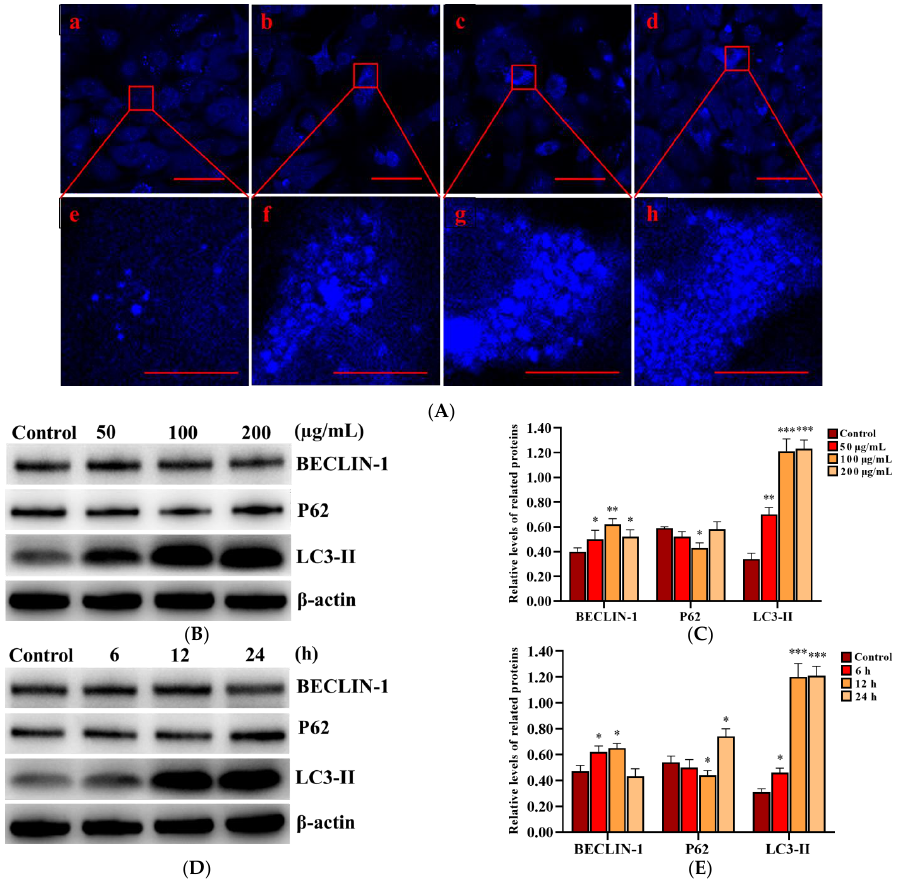
Figure 4. Effect of SNPs on the activation of autophagy in PLCs. ( A ) Fluorescence images of MDC staining. PLCs were exposed to 0, 50, 100, and 200 µg/mL SNPs for 12 h. Scale bar: 50 µm ( A a – d) and 10 µm ( A e – h). ( B ) Western bolt analysis of BECLIN-1, P62, and LC3-II levels. PLCs were exposed to 0, 50, 100, and 200 µg/mL SNPs for 12 h. ( C ) Quantification of the band intensity in B is presented as the relative ratio of target proteins to β -actin. ( D ) Western bolt analysis of BECLIN-1, P62, and LC3-II levels. PLCs were exposed to 100 µg/mL SNPs for 0, 6, 12, and 24 h. ( E ) Quantification of the band intensity in D is presented as the relative ratio of target proteins to β -actin. Data are presented as the mean ± SEM of three independent experiments. * Statistically different from the control is marked with asterisks (* p < 0.05, ** p < 0.01, and *** p < 0.001).